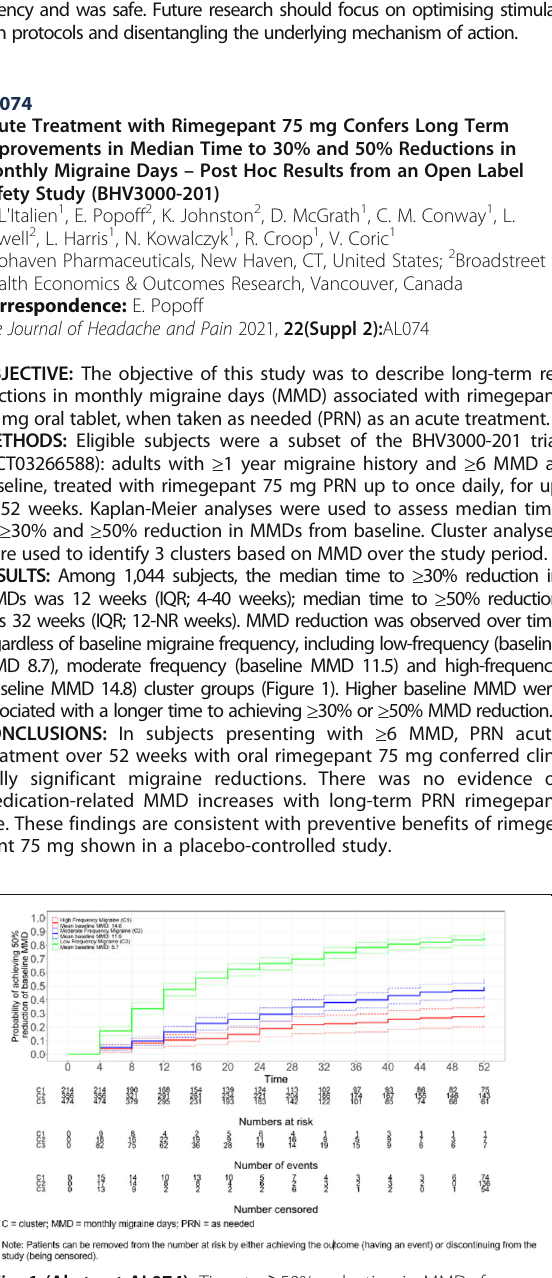
Fig. 1 (Abstract AL074). Time to ≥ 50% reduction in MMDs from baseline by mean baseline MMD group Fig. 1 (abstract AL076). See text for